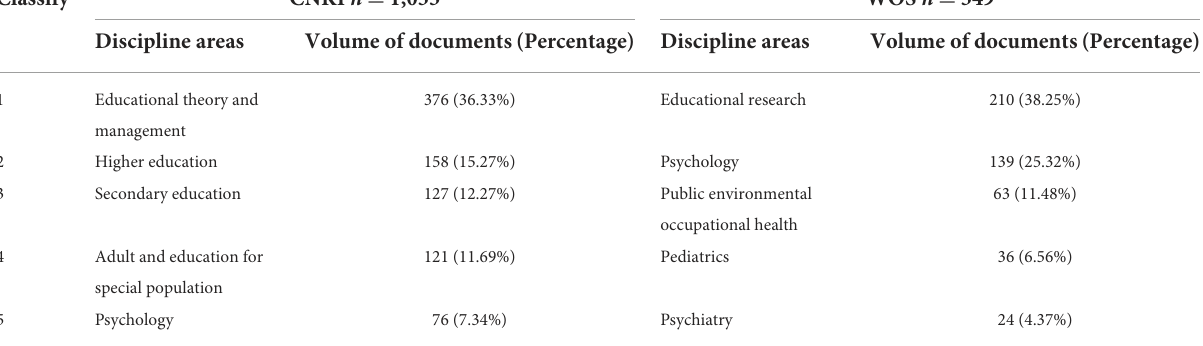
TABLE 2 Research discipline areas (top